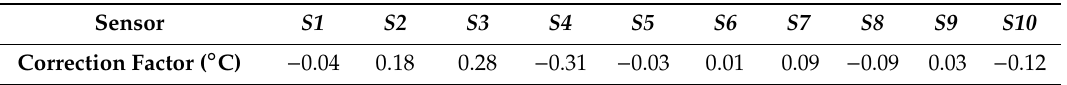
Table 2. Correction factors to be implemented in the temperature measurement of each sensor.